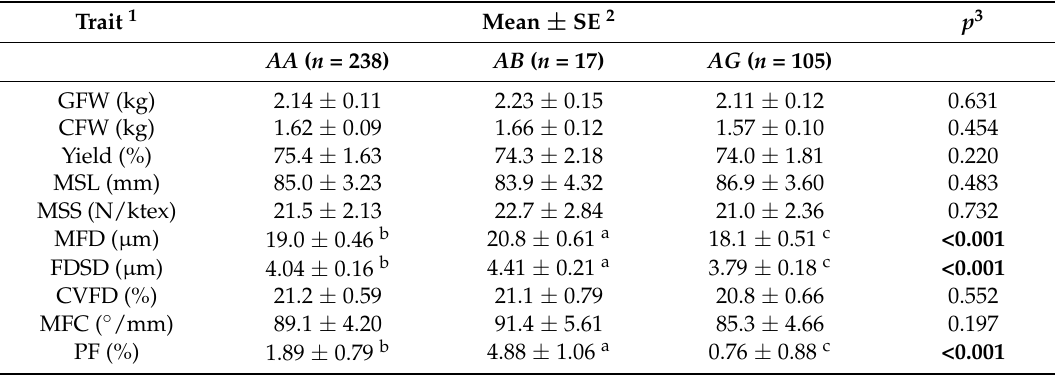
Table 1. The association of KRTAP6-3 genotype and various wool